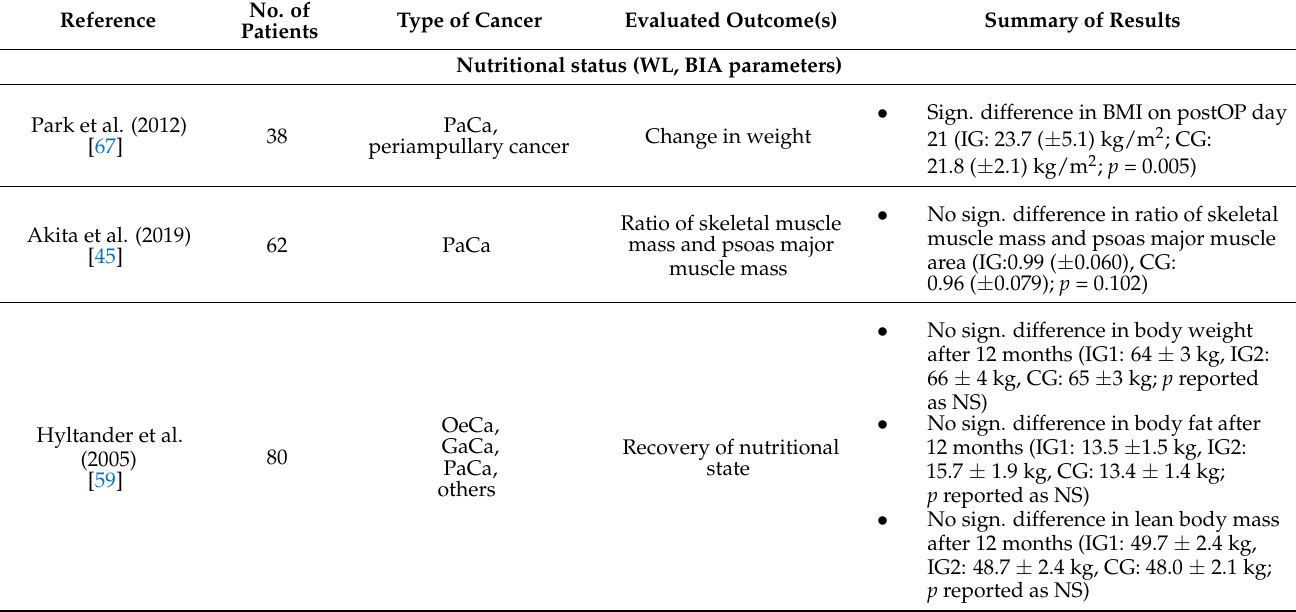
Table 5. Randomized controlled trials of mixed and special forms of nutritional